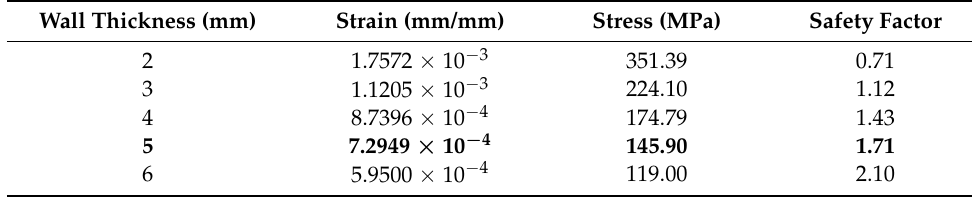
Table 2. Result of safety factor calculation using ANSYS